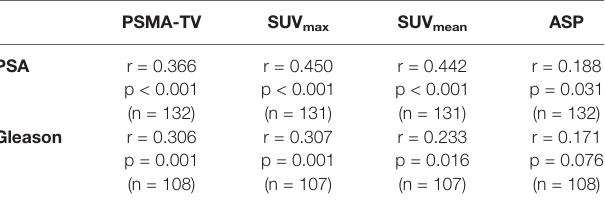
TABLE 2 | Correlation between initial PSA values and biopsy-derived Gleason scores with quantitative PSMA-PET parameters. PSMA-TV SUV max SUV mean